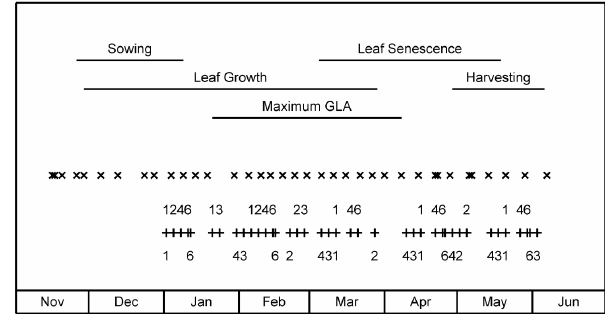
Fig. 2. Picture taken on the largest field at the irrigation limit Figure 2. Picture taken on the largest field at the irrigation limit (before sowing). (before sowing).